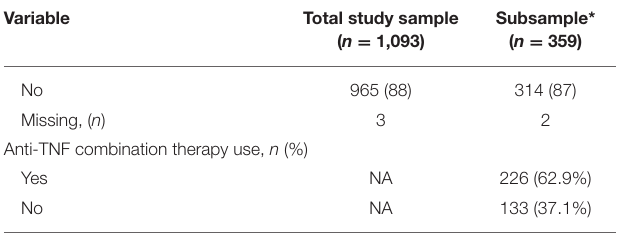
TABLE 1 | Characteristics of total study sample and subsample with information on combination therapy